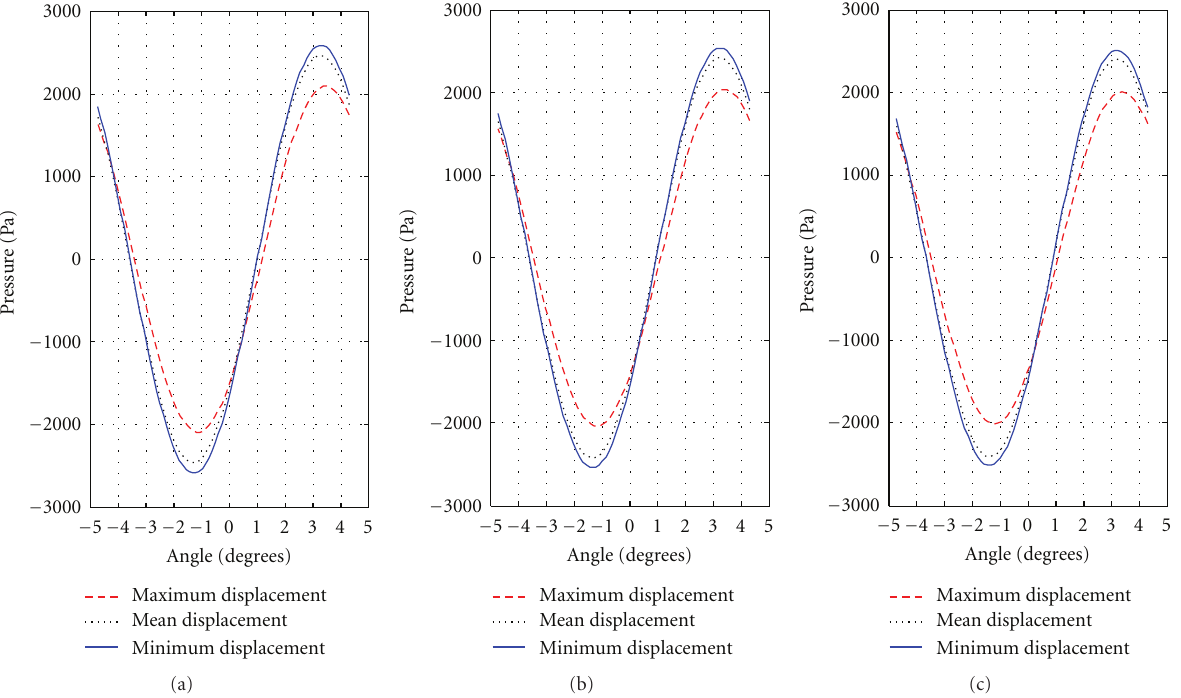
Figure 15: First spatial harmonic of the pressure across each of the three polylines, shown in Figure 4(d), when the blade deflection goes through its range of motion from maximum deflection, through mean deflection and to its minimum deflection position. (a) Polyline at tip of blade (b) polyline between surface and blade tip, and (c) polyline at casing surface.